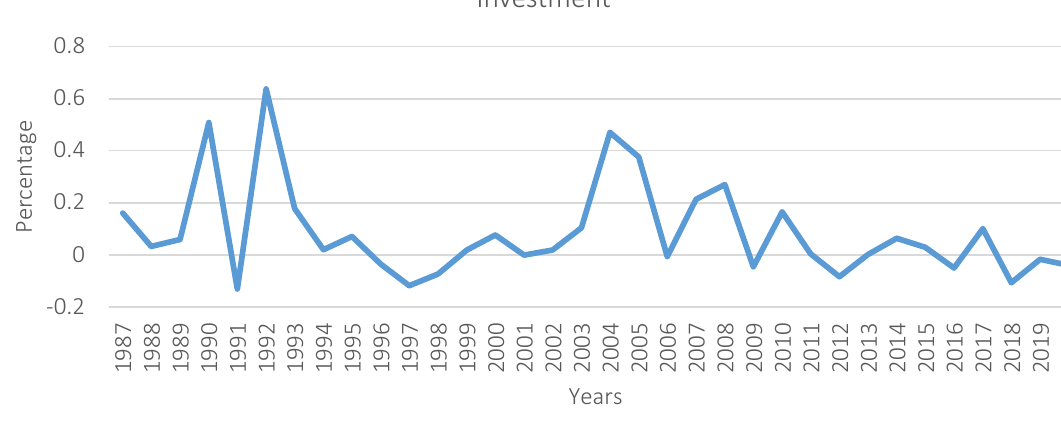
Figure 1. Investment